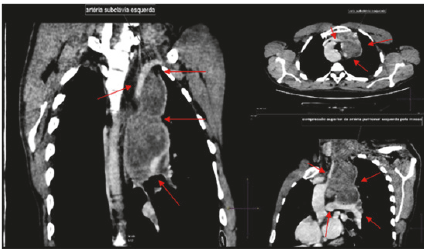
Figure 4: Chest tomography in axial, coronal and sagittal sections demonstrating the mediastinal masses and their relations with some mediastinal vessels (white and red arrows).